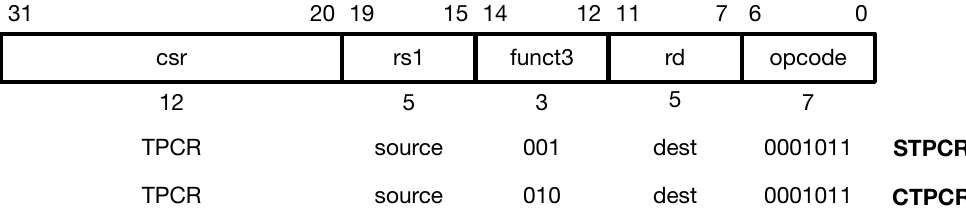
Figure 4. TPCR updating